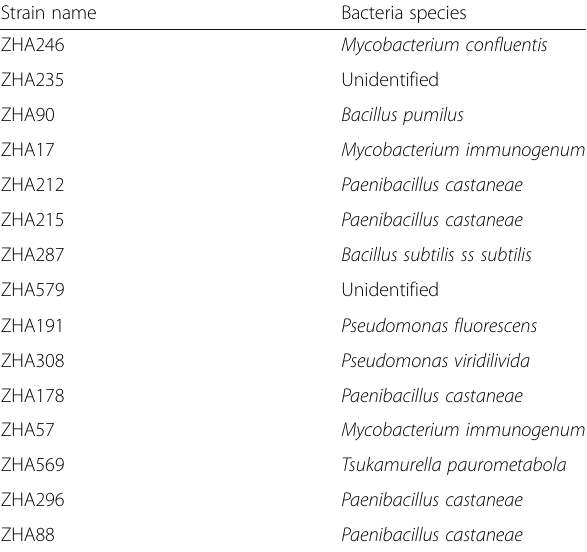
Table 1 The plant growth-promoting rhizobacteria (PGPR) strains used as treatments in the